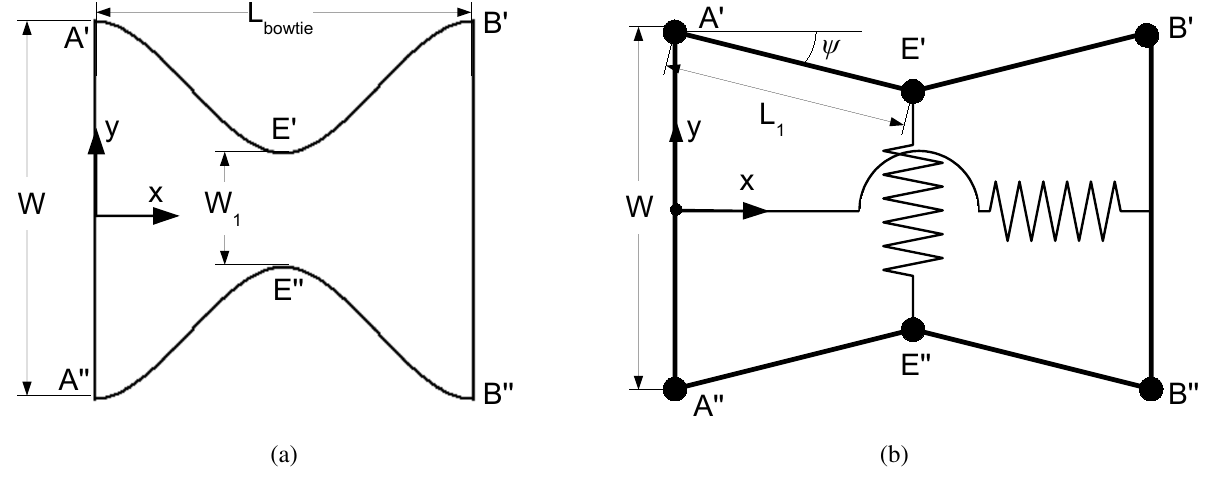
Figure 13. Deformed bowtie linear actuator ( a ) when the bender angle θ = 0 . The model of the bowtie ( b ) is a six bar mechanism with one spring along the x (actuation) direction and one spring in the y direction. The y direction spring couples the deformation in y (change in λ ) with force in the actuation direction x y